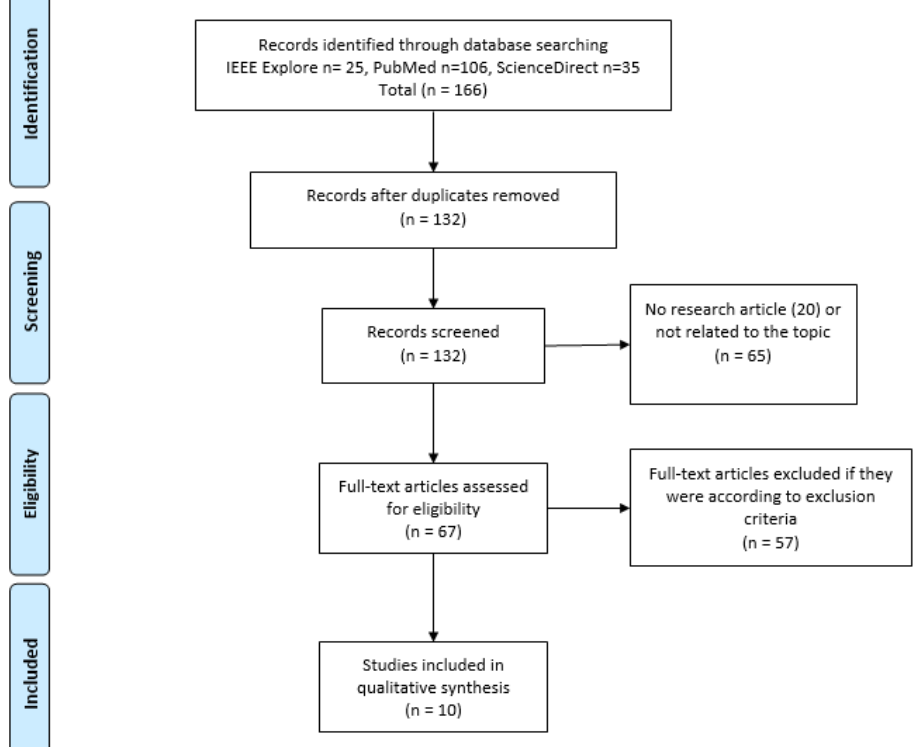
Figure 1. PRISMA diagram of the bibliographic review conducted.